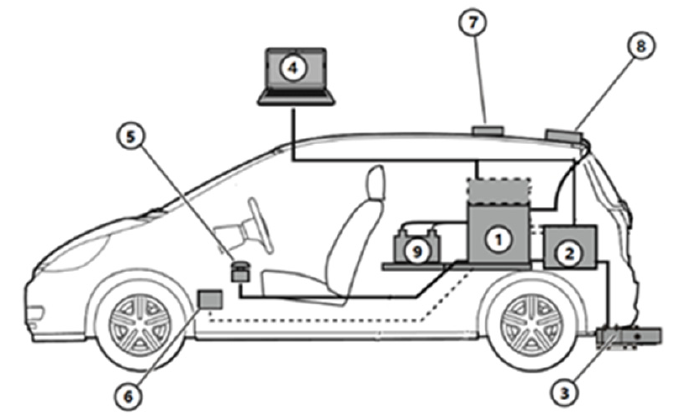
Figure 1. Schematic diagram of PEMS installation. ① Gas analysis module, ② PN counting module, ③ exhaust gas flow meter, ④ control computer, ⑤ emergency stop switch, ⑥ OBD communication connection, ⑦ GPS, ⑧ weather station, and ⑨ external battery. The OBS-ONE system requires a DC power supply of 22–28 V. Non-Dispersive Infra- Red (NDIR) is used to determine CO and CO 2 concentrations. Chemiluminescence Detec-